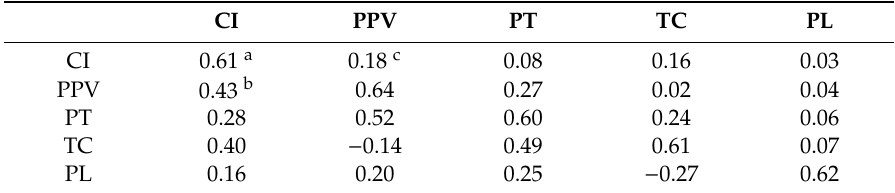
Table 4. Average Variance Extracted and Squared Correlations of